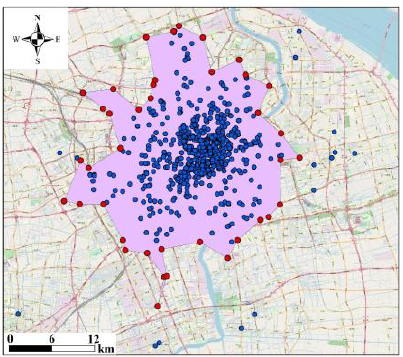
Figure 10. The boundary of origin points of emergency travels.